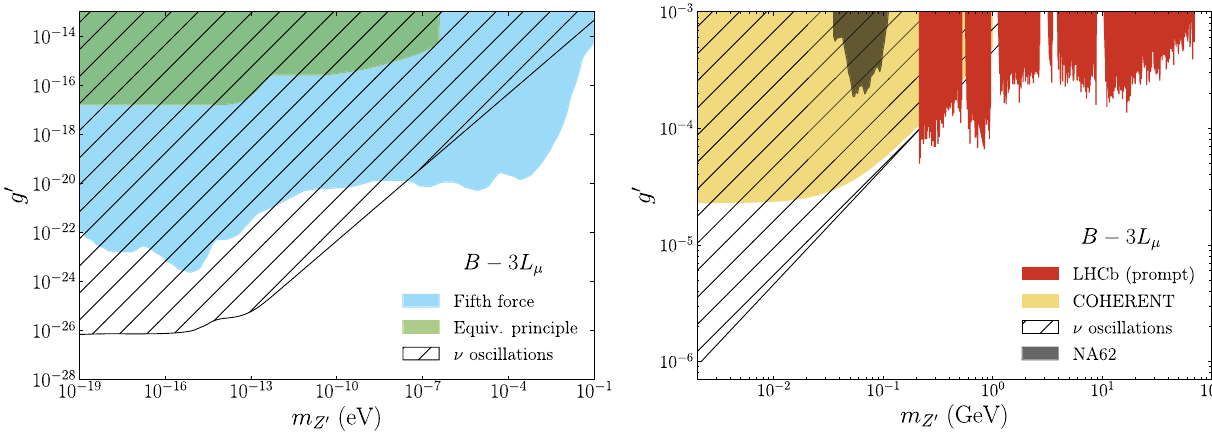
Fig. 4 Regions of parameter space ruled out from oscillation data, for a light Z (cid:15) arising from a model with gauged U ( 1 ) (cid:15) symmetry. The left panel shows the comparison for ultra-light mediators in the long-range domain, while the right panel shows the comparison in the NSI limit